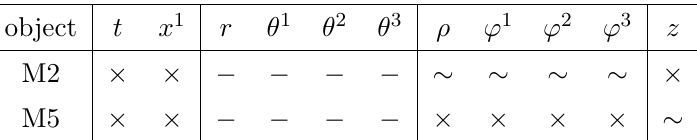
-BPS brane system underlying the intersection of M2–M5 branes intersecting M5 Table 4 . The 1 4 branes. The conical singularity is located within the R 4